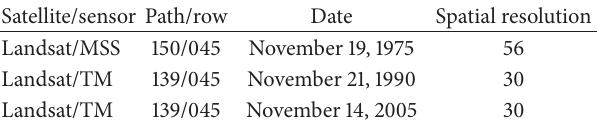
Table 2: Details of the Landsat images used in the study. Satellite/sensor Path/row